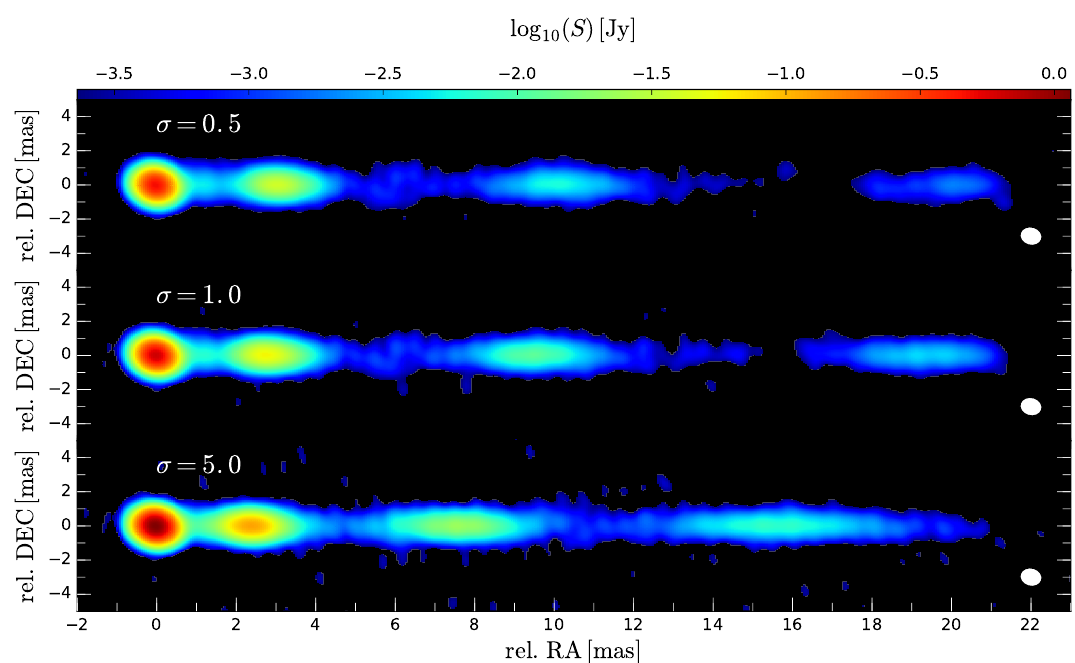
Figure 2. Radio maps (15GHz) using the Very Long Baseline Array (VLBA) as the observing array for different initial magnetisations (indicated in top left corner). The convolving beam of 1.12mas × 0.57mas is plotted in the lower right